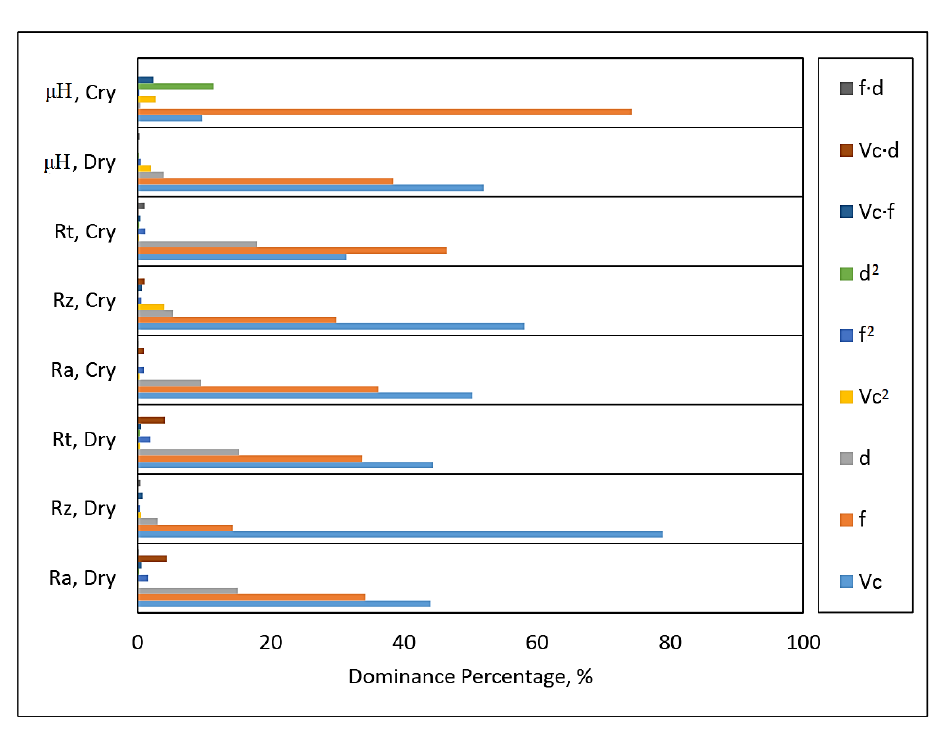
Figure 5. Dominance percentage of each process parameter in different turning conditions.